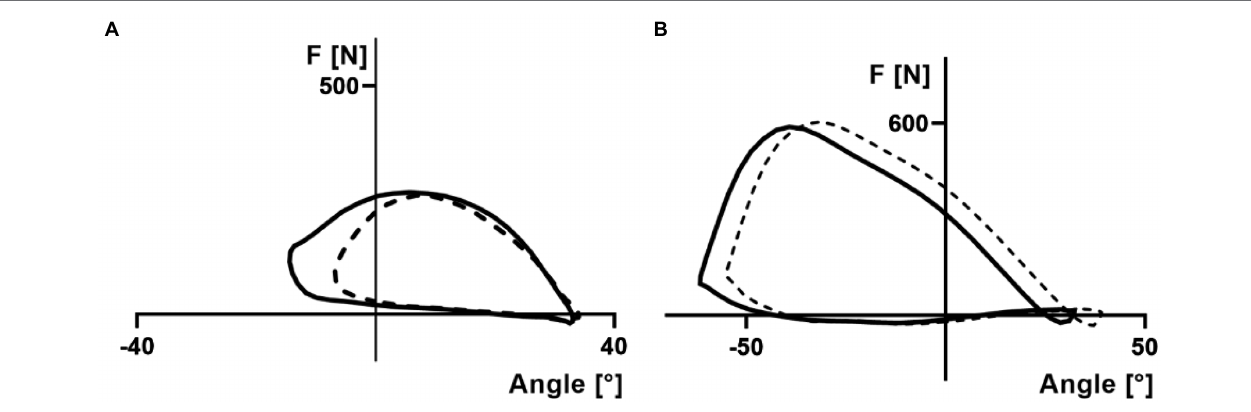
FIGURE 3 | Representation of the average handle force (F) as a function of rowing angle during proof-of-concept ( A ; indoor rowing tank measurements) and single case repeated measurement ( B ; in-field boat measurements) and indoor rowing tank measurements (B) . GATE is displayed in solid lines and NORM in dashed lines.